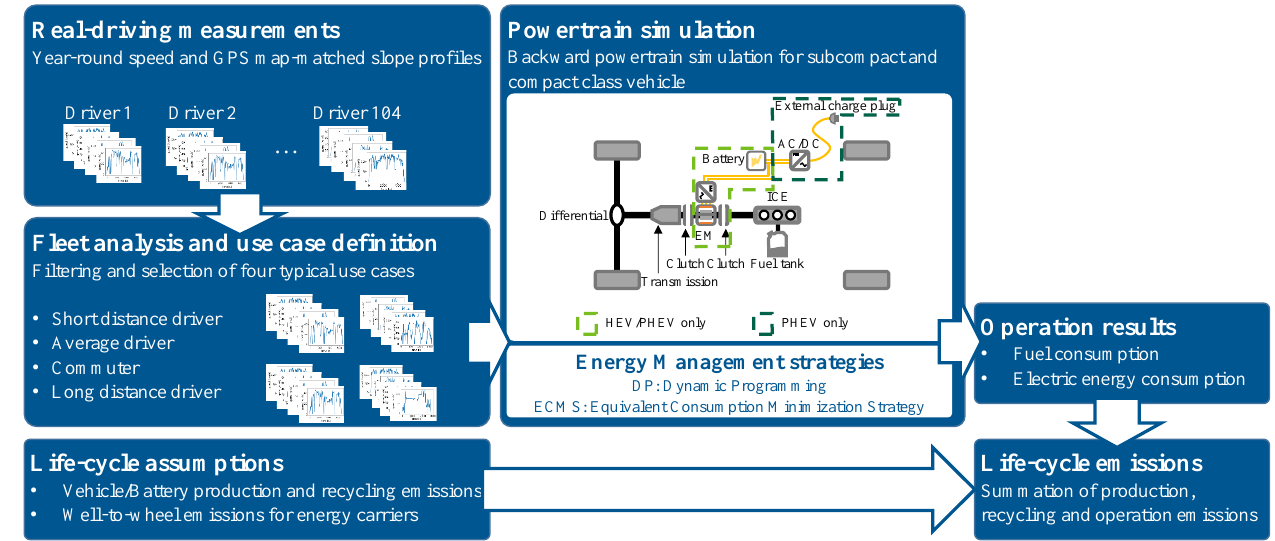
Figure 1. Schematic diagram of conducted LCA.